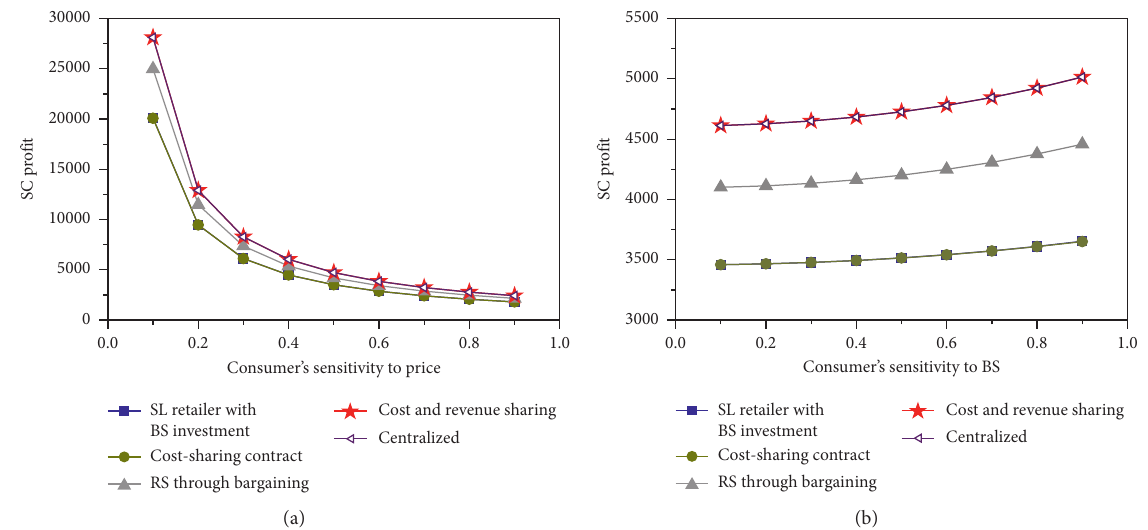
Figure 4: (a) The effect of optimal b on the expected profits of the SCs. (b) The effect of optimal β on the expected profits of the